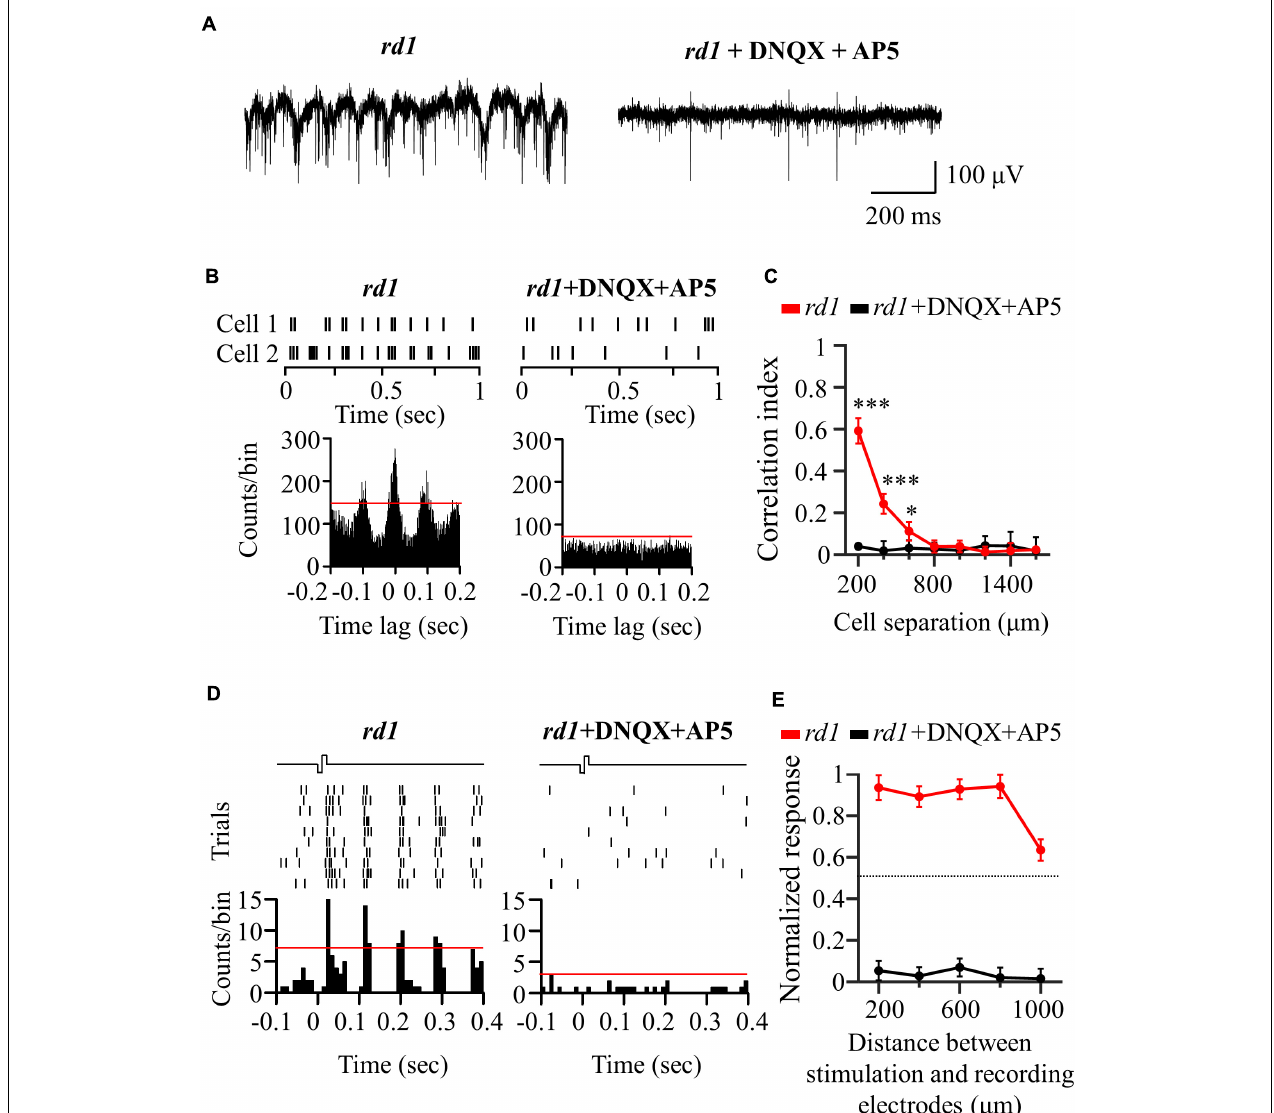
FIGURE 5 | Application of glutamatergic receptor blocker (DNQX and DL-AP5) completely blocked network-mediated RGC responses in the rd1 retina. (A) Representative raw traces of RGCs were shown for 1 s in rd1 mice without and with glutamate receptor blockers. (B) Changes in synchronized firing between rd1 RGCs after drug application. Top panels: raster plot of RGC with 200 µ m spacing on the MEA. Lower panel: cross-correlogram between RGCs. The time bin for correlograms is chosen to be 2 ms. The red line indicates the significance level represented by the 99% confidence limit of the correlogram. (C) CCI as a function of inter-RGC distance. The statistical differences before and after drug application are indicated by asterisks (*** p < 0.001, * p < 0.05). (D) The responses of RGC that is 200 µ m away from the stimulation electrode to electrical stimulation with a pulse amplitude of 50 µ A and a pulse duration of 500 µ s. Top panels: raster plot of rd1 RGC (10 trials). Lower panel: PSTHs. The time bin for PSTH is chosen to be 10 ms. The red line indicates the significance level, expressed as the 99% confidence limit for PSTH. (E) Normalized RGC response to electrical stimulation (pulse amplitude: 50 µ A, pulse duration: 500 µ s) with the distance between stimulation and recording electrodes without and with the presence of glutamate receptor blockers.